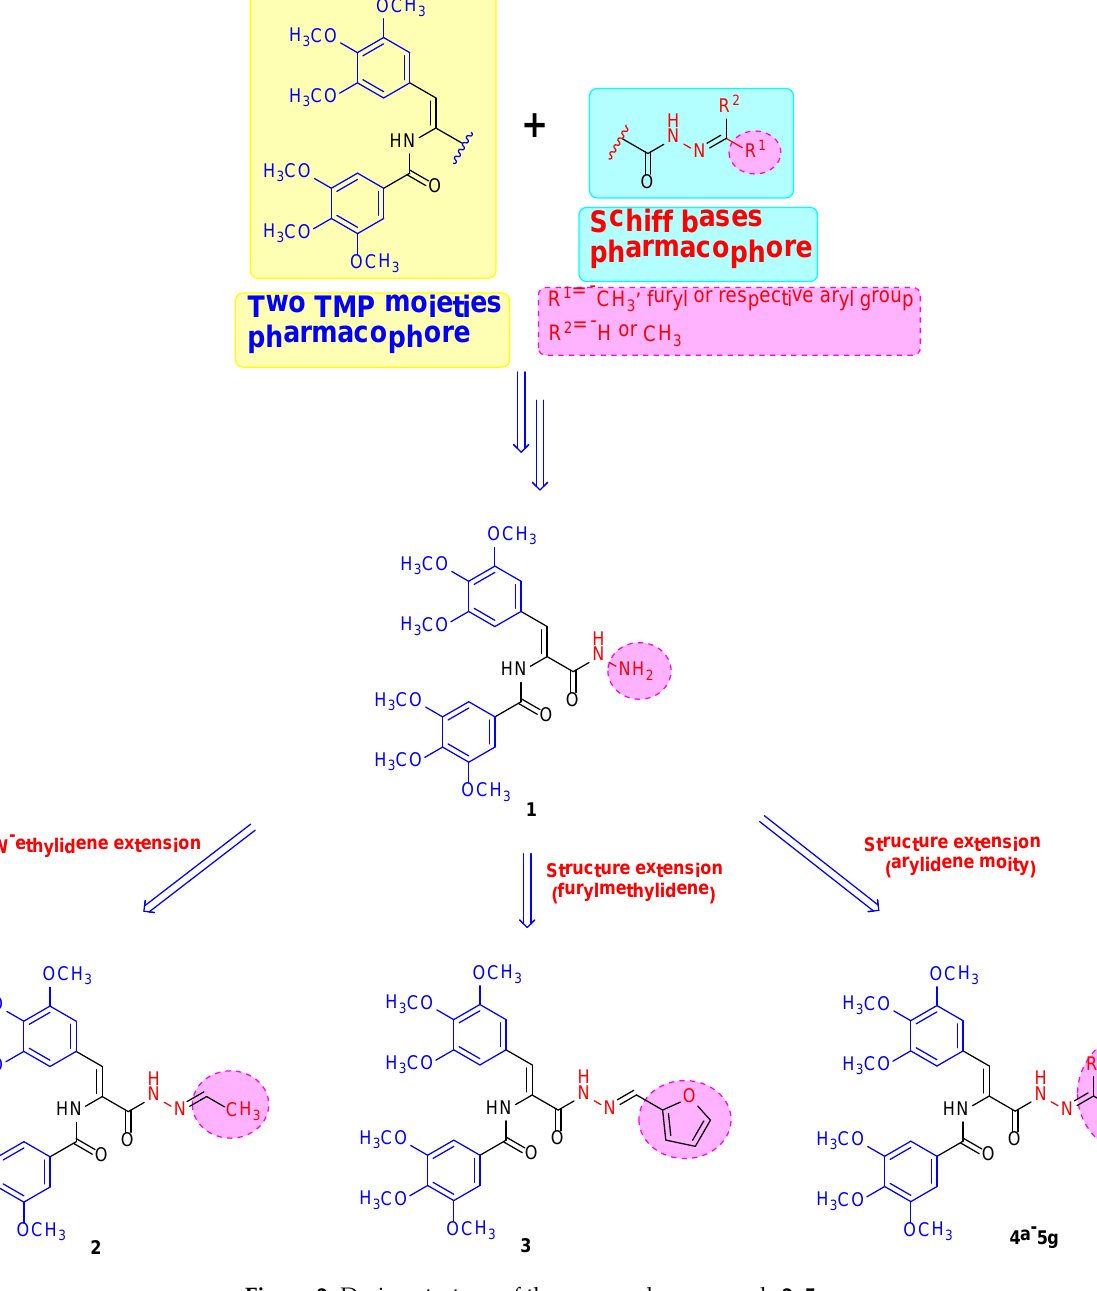
Figure 2. Design strategy of the prepared compounds 2–5g .